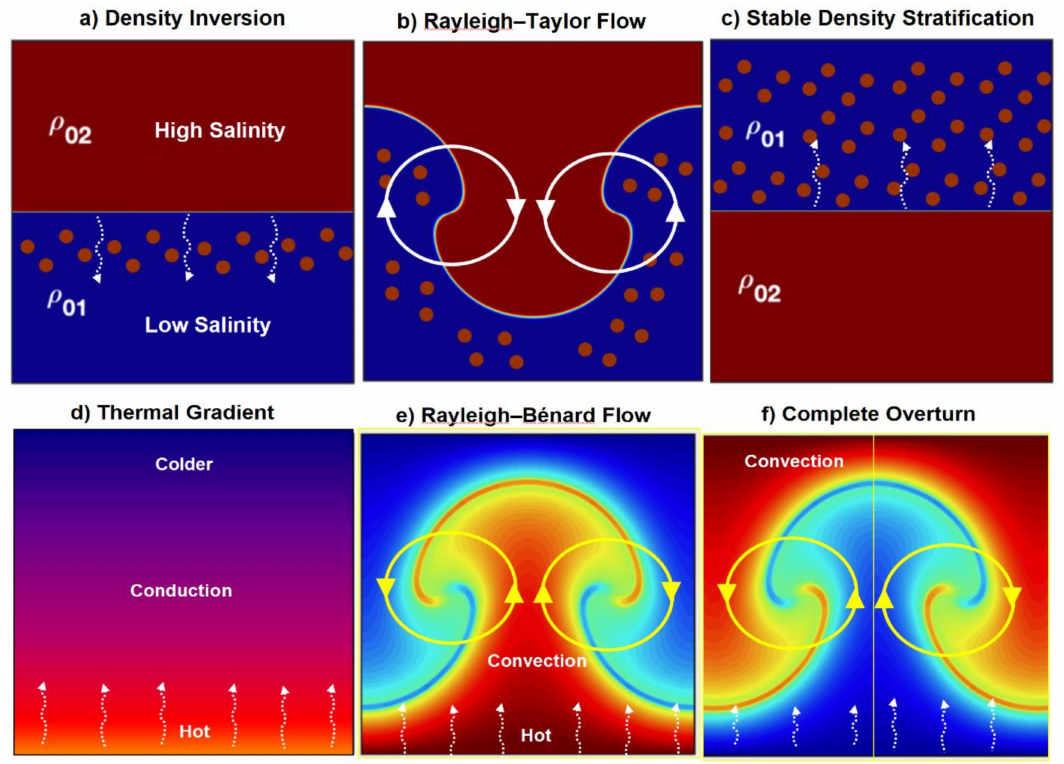
Figure 1. Principle sketches of molecular diffusion, heat diffusion and advective mass transport (convection) in typical cases of ( a – c ) RT instability and ( d – f ) RB instability. Dashed arrows show net direction of diffusive transfer; solid vortices show direction of advection. Bottom row includes excerpts from Dharodi and Das [1]; however, the sketches shown here are merely demonstrating physical principles and are not intended to be accurately